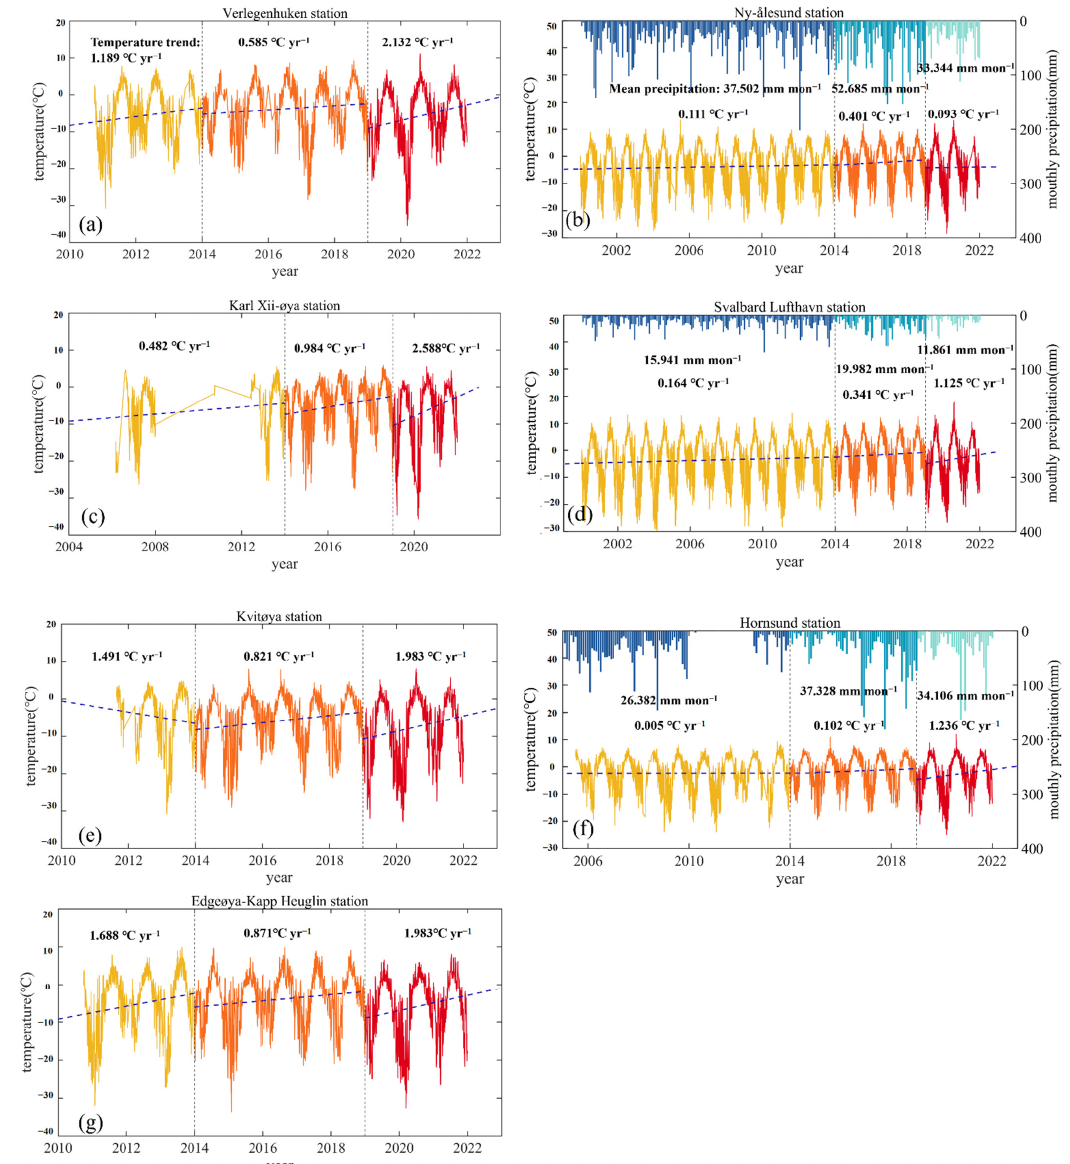
Figure 4. The temperature and precipitation data collected by the gauge stations. ( a ) Verlegenhuken station. ( b ) Ny-ålesund station. ( c ) Karl Xii-øya station. ( d ) Svalbard Lufthavn station. ( e ) Kvitøya station. ( f ) Hornsund station. ( g ) Edgeøya-Kapp Heuglin station.